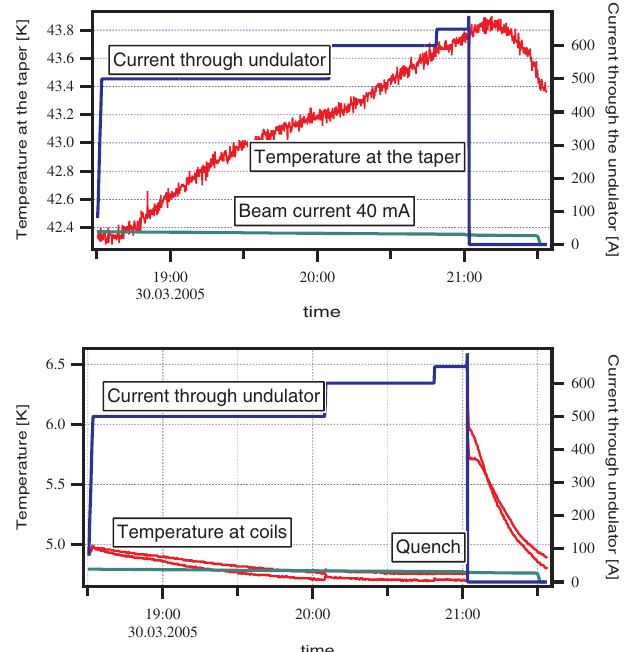
FIG. 6. (Color) The first graph shows that the x-ray beam generated by the undulator hits the taper and warms it. In the second graph it is shown that this does not influence the temperature of the coils. At the end of the run the undulator is forced to quench. The recovery time is quite short and after about half an hour there is a return to the previous